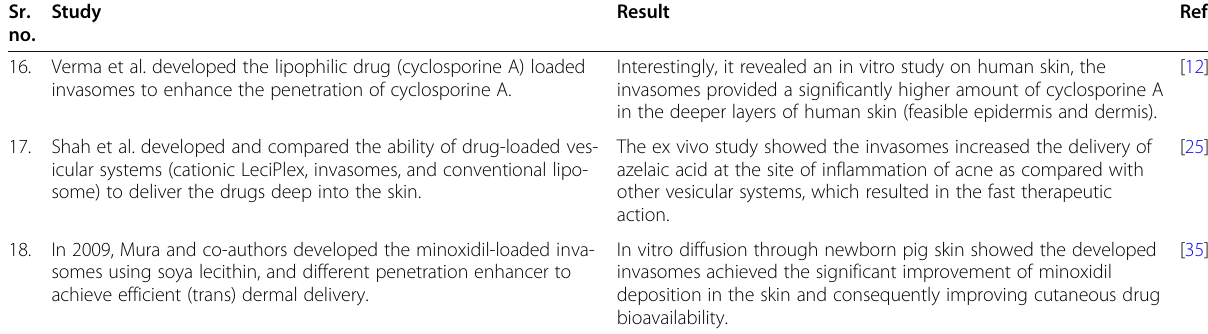
Table 3 Pharmacokinetic study of invasomes (Continued) Sr. no.